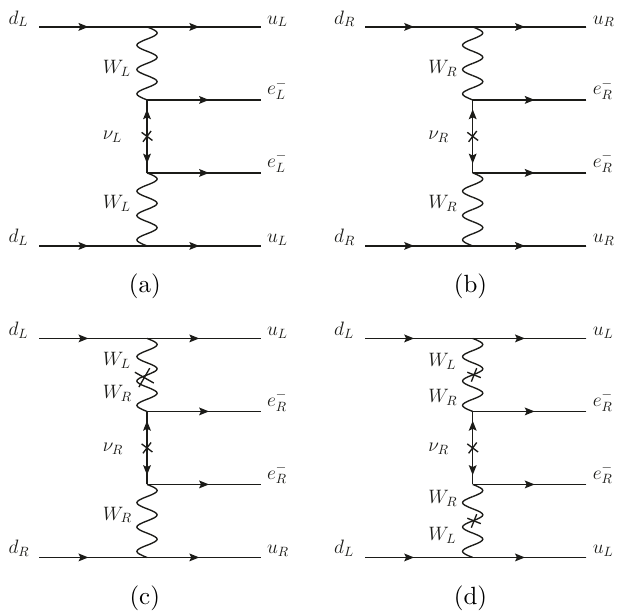
Figure 2. The diagrams responsible for the 0 νββ decay independent of the Dirac mass term. The cross vertices ( × ) in the fermion lines of ν M L and M R , respectively, while that in between W L − W R denotes the left-right mixing. In the limit of type-II dominance, there is no mixing between ν